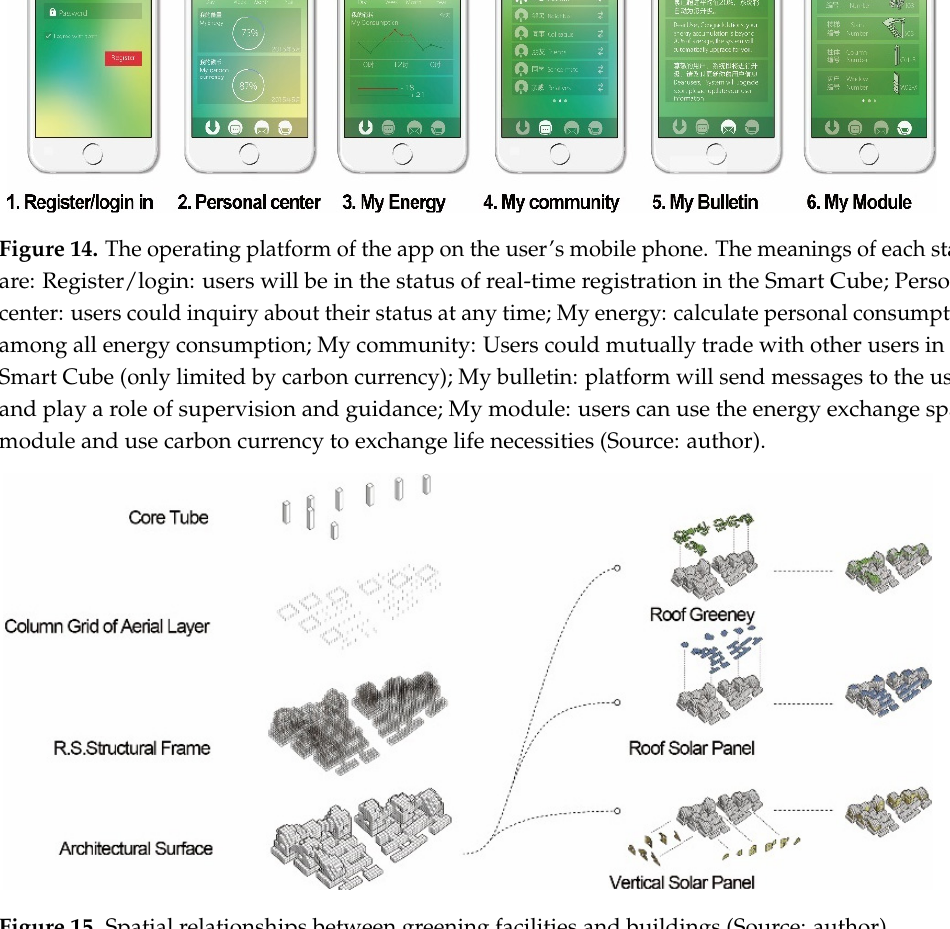
Figure 16. Schematic diagram for the adaptive structure system and architectural space module (Source: author).